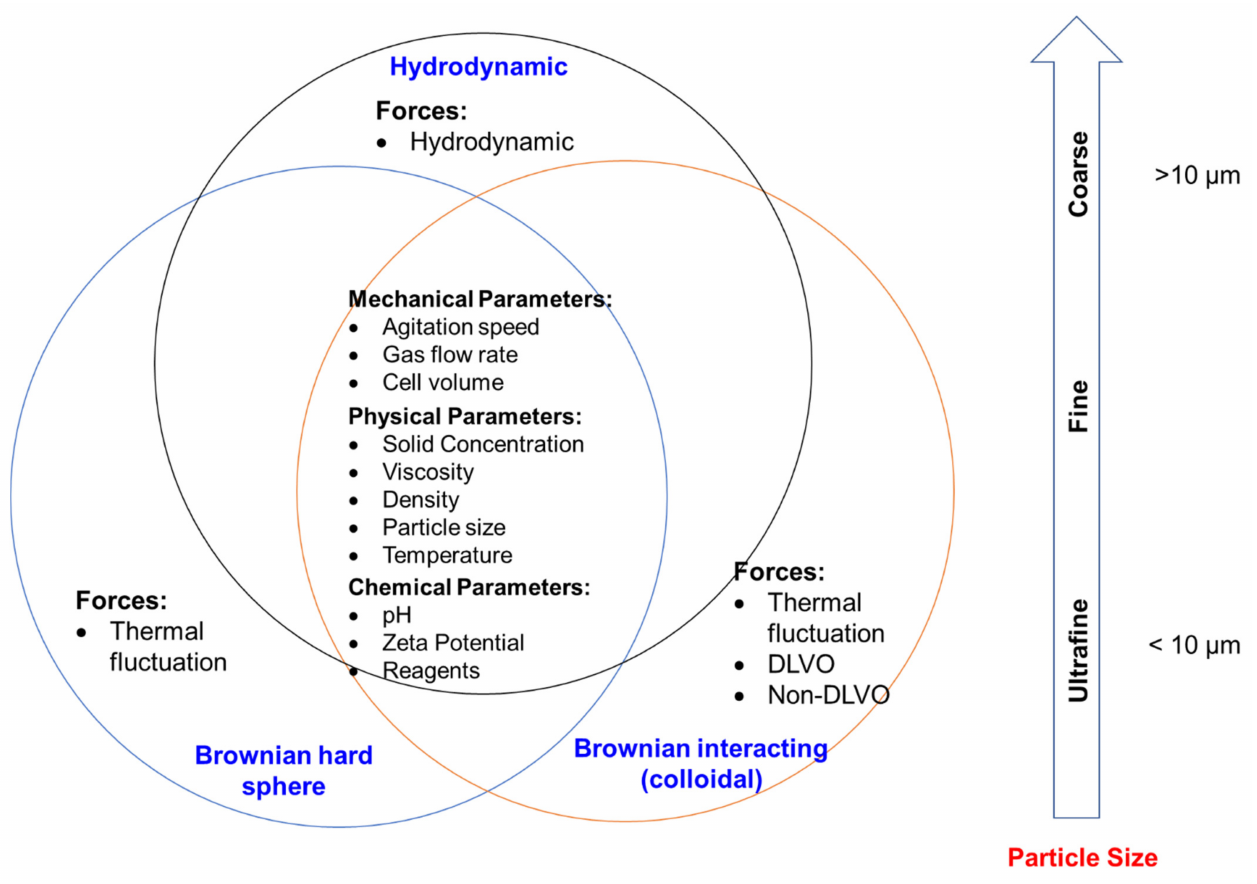
Figure 4. Particle size ranges and their associated flow regimes, forces, and parameters influencing flotation